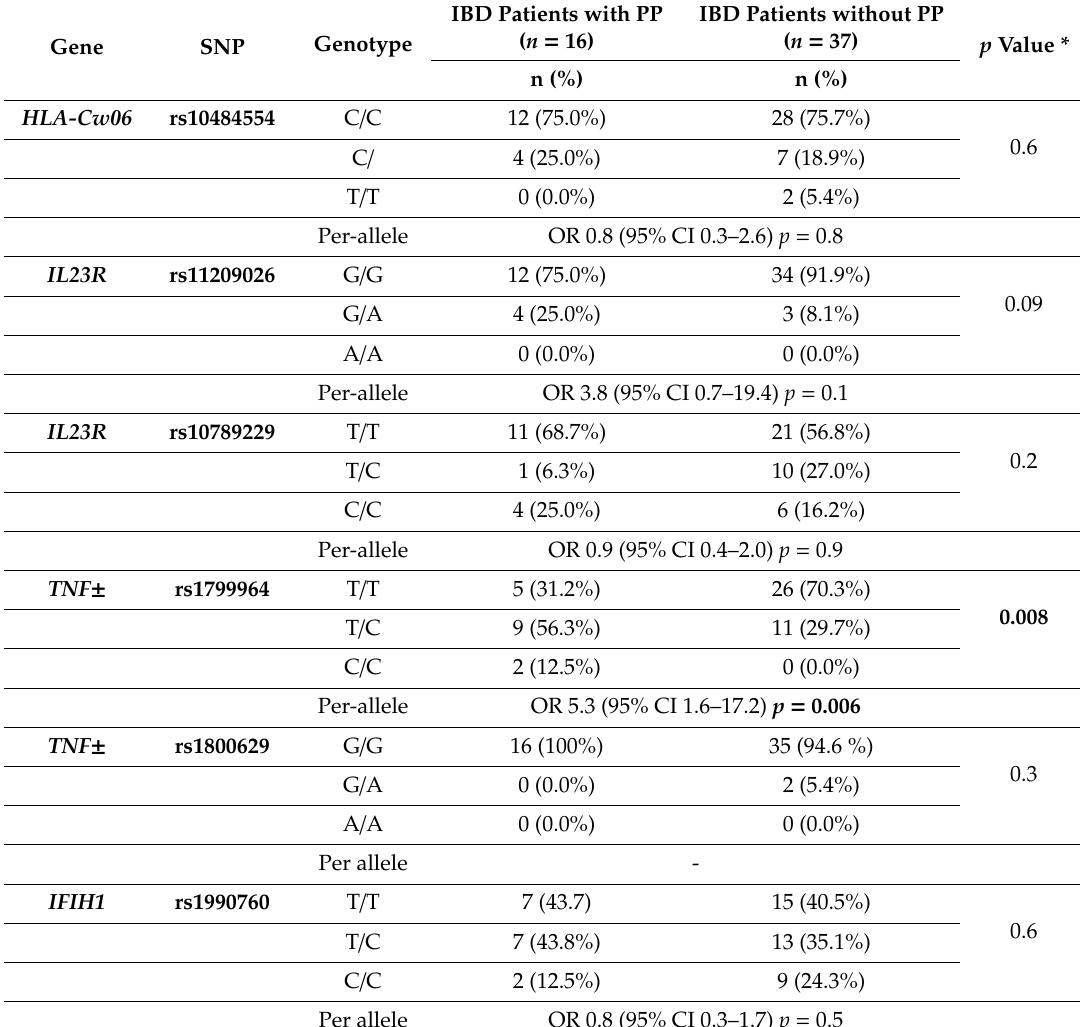
Table 3. Distribution of IBD patients with and without PP according to the genotype frequencies of the six single nucleotide polymorphisms (SNPs)